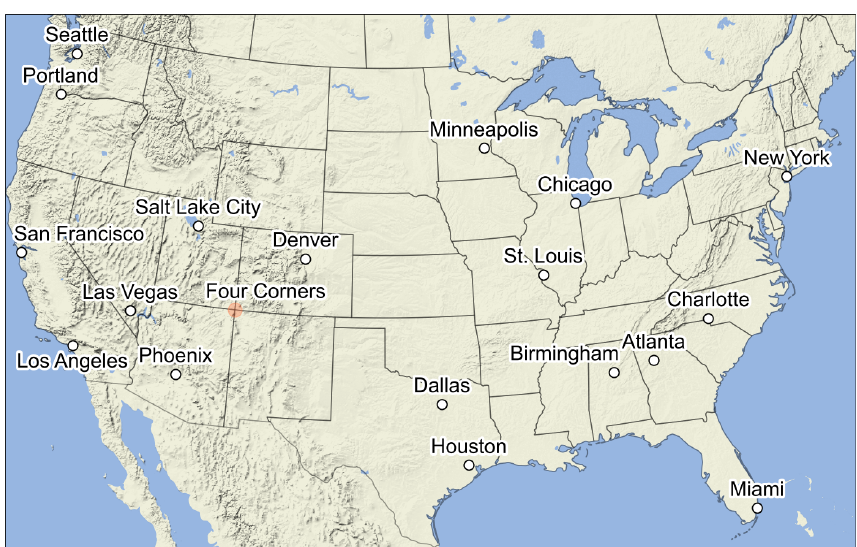
Figure C1. Map of the contiguous US. Locations discussed in the text and locations with notable features in Fig. 7 are